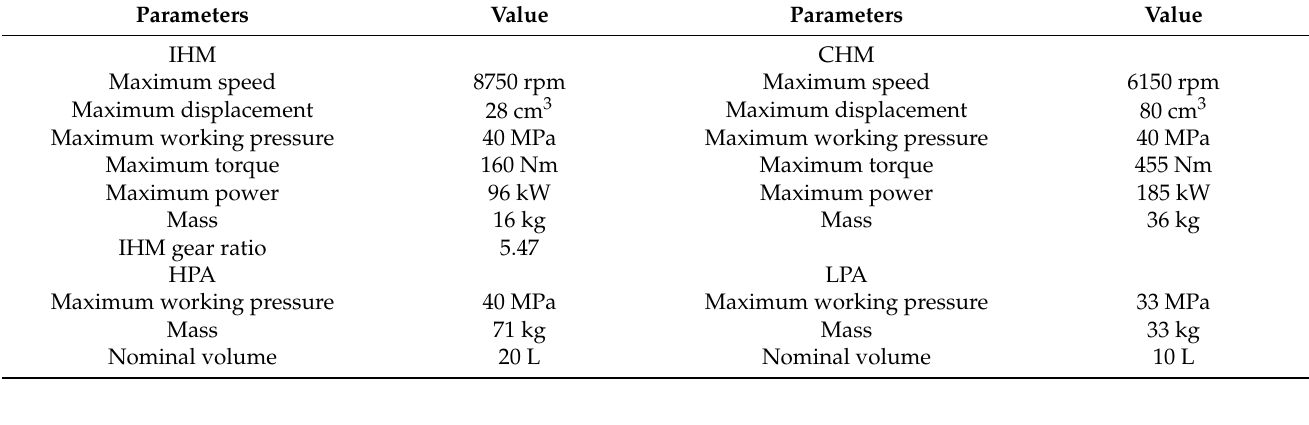
Table 3. Parameters of IHV.